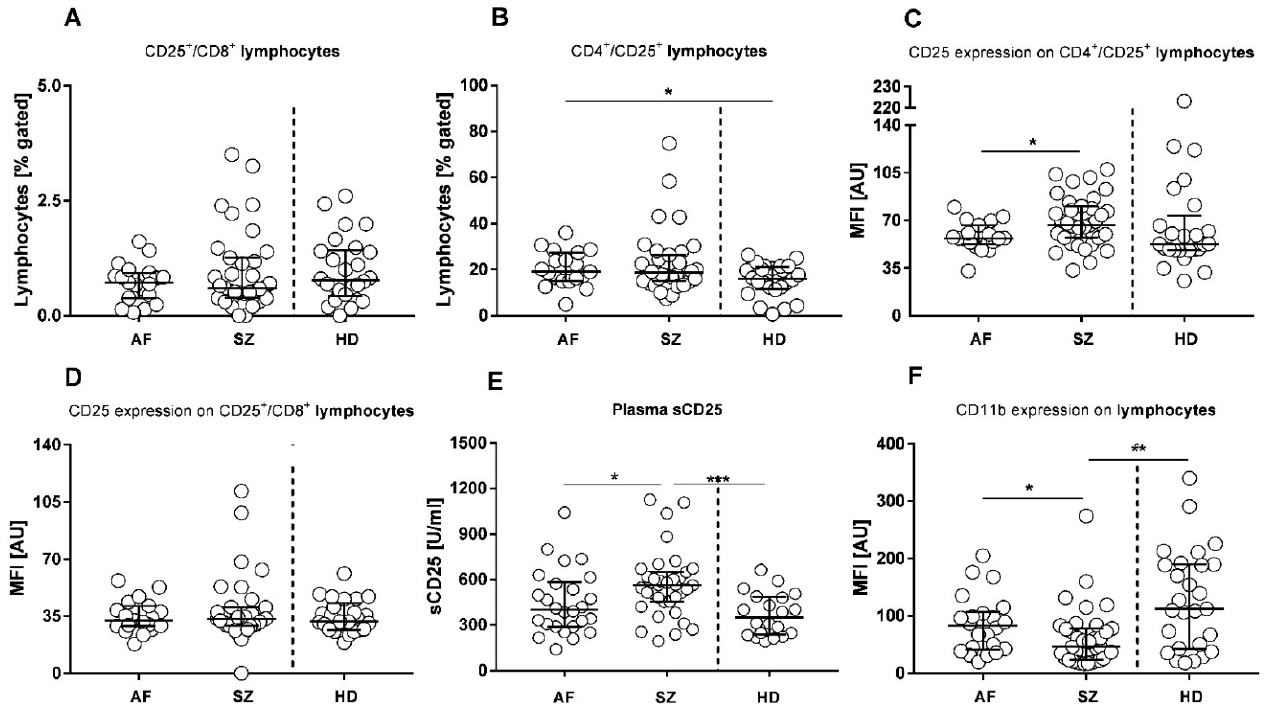
Figure 5. Flow cytometric profiles related to autoimmunity in patients with AF, SZ, and HDs. Relative amounts (% gated) of CD25 + /CD8 + lymphocytes ( A ) and CD4 + /CD25 + lymphocytes (comprising activated and T reg cells, AF/HDs: median: 19.07 vs. 15.95, p = 0.05) ( B ) are shown. Expression densities of CD25 on T reg cells (AF/SZ: median: 56.85 vs. 68.79, p = 0.005) ( C ), and on cytotoxic T cells ( D ) are shown and given as arbitrary units (AU). Plasma sCD25 levels are shown (AF/SZ: median: 400.0 vs. 562.0, p = 0.03; SZ/HDs: median: 562.0 vs. 350.1, p ≤ 0.001) ( E ). Lymphocyte expression densities of CD11b are shown ( F ) and given as arbitrary units (AU). Bars indicate the respective medians, including interquartile ranges. Wilcoxon rank-sum test was performed to analyze differences among groups, with significant differences being marked by * p ≤ 0.05, ** p ≤ 0.01, and *** p ≤ 0.001.